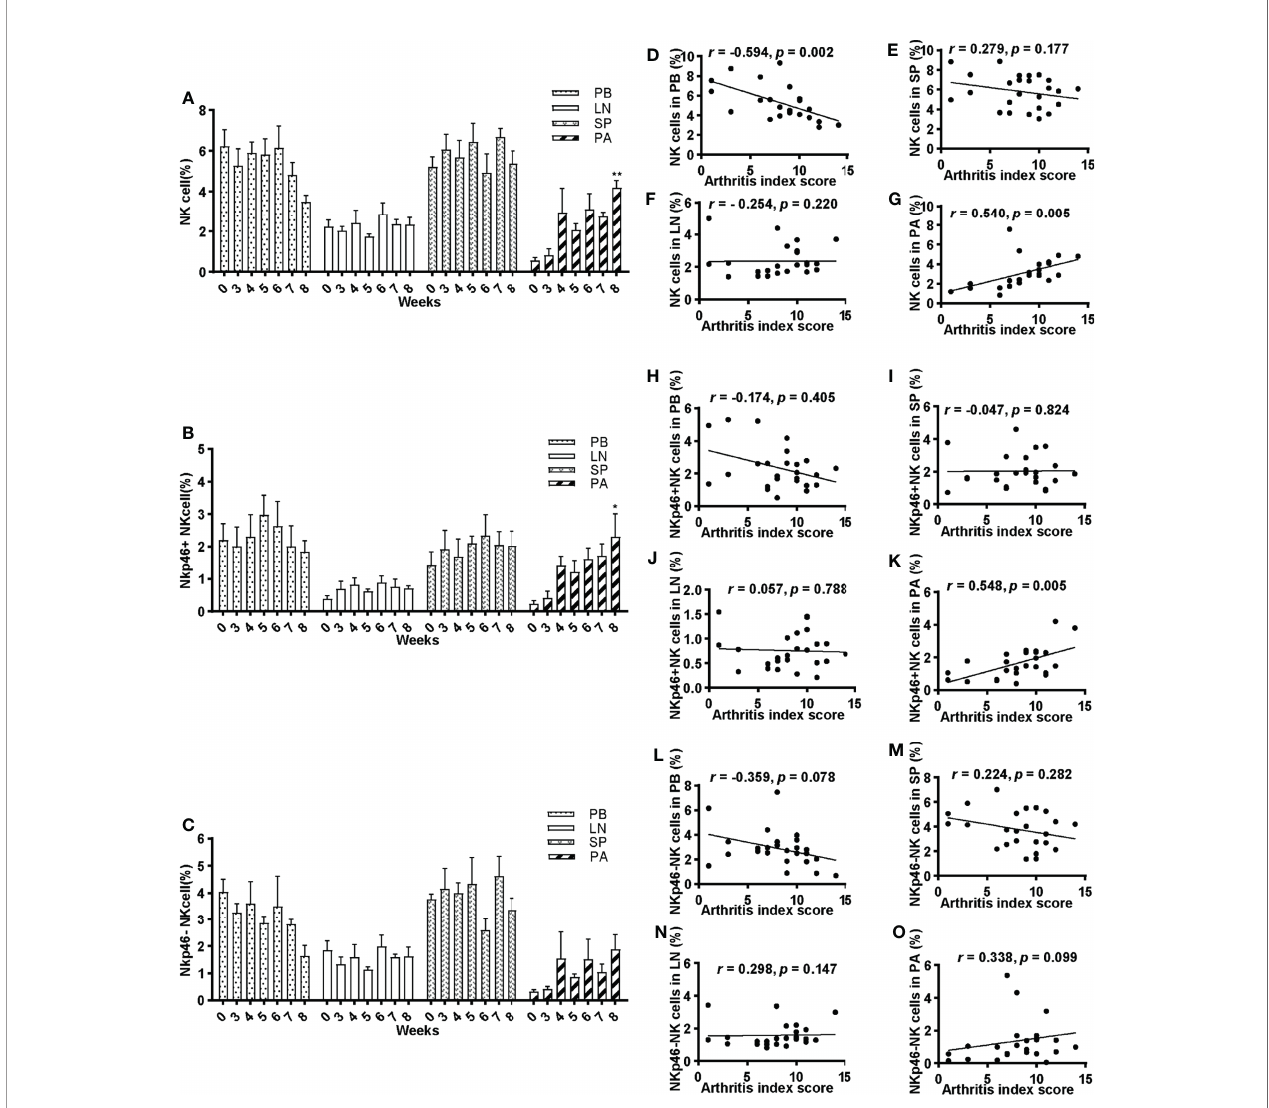
FIGURE 3 | Frequencies of NK cells and their correlations with arthritis index score. (A – C) Percentage of NK cells, NKp46 + NK cells, and NKp46 − NK cells of lymphocytes in peripheral blood, spleen, lymph nodes, and paws at 0, 3, 4, 5, 6, 7, and 8 weeks post fi rst immunization, respectively. ANOVA was used for comparing NK cells in PB and SP; NKp46 + NK cells in LN and SP; NKp46 - NK cells in PB; others by Kruskall – Wallis test. *p < 0.05, **p < 0.01 after adjusted by the Bonferroni correction vs. week 0. PB, peripheral blood; LN, lymph nodes; SP, spleen; PA, paws. (D – O) Correlations of NK cells, NKp46 + NK cells, and NKp46 − NK cells in peripheral blood, spleen, lymph nodes, and paws with arthritis index scores were explored. Pearson correlation analyses were used for D, F, G, I, L, N, and Spearman analyses for others. n = 5 per group. Results are representative of three independent